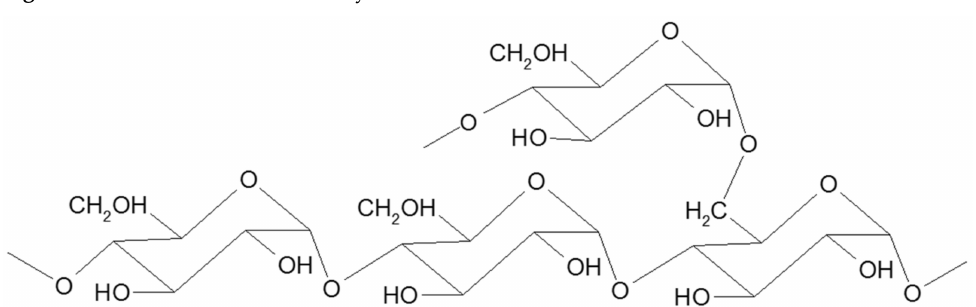
Figure 1. Schematic structure of amylose.